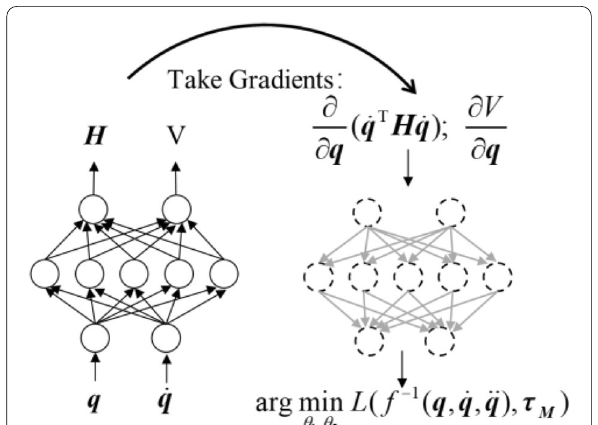
Figure 5 Structure of DeLaN